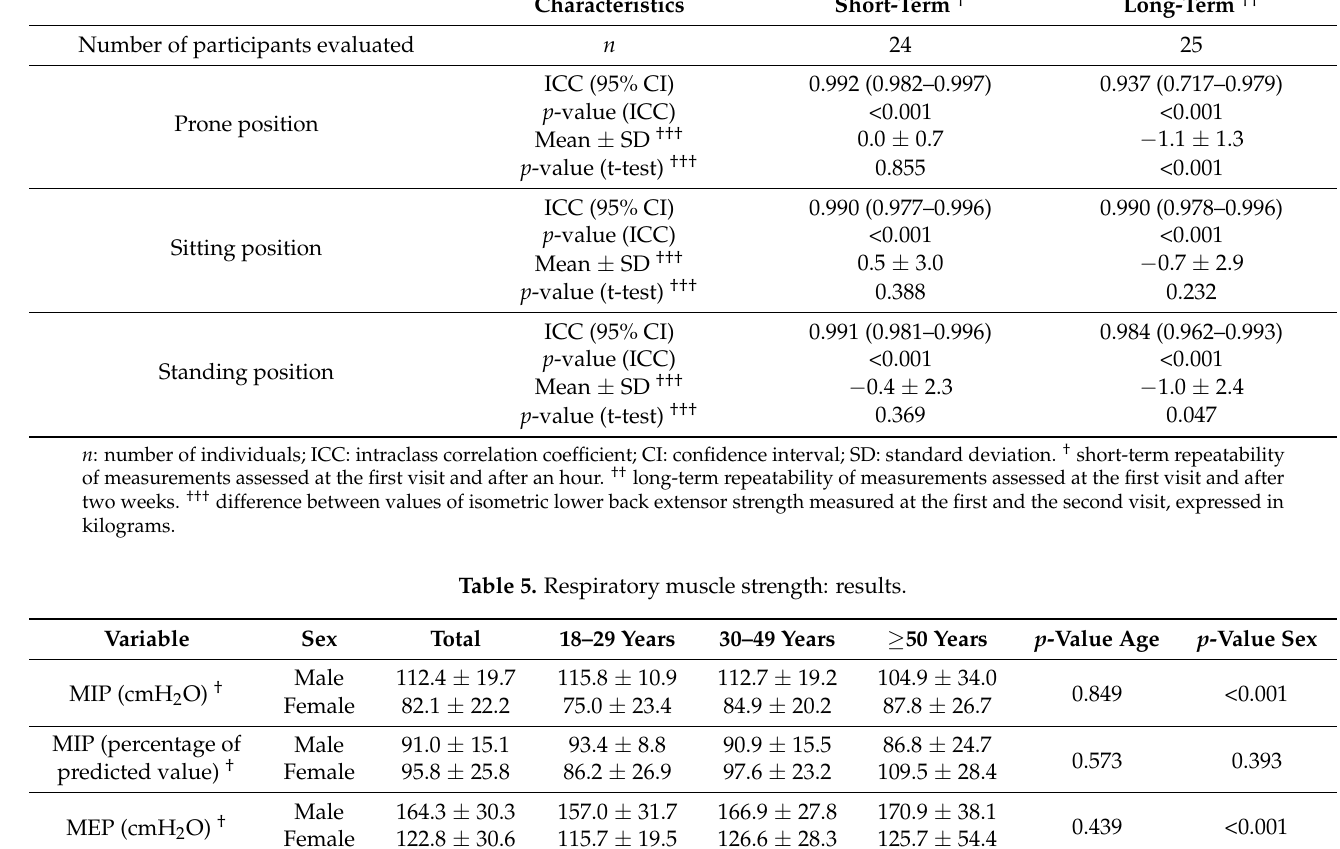
Table 4. Maximal isometric lower back extensor strength: short-term and long-term test-retest reliability. Characteristics